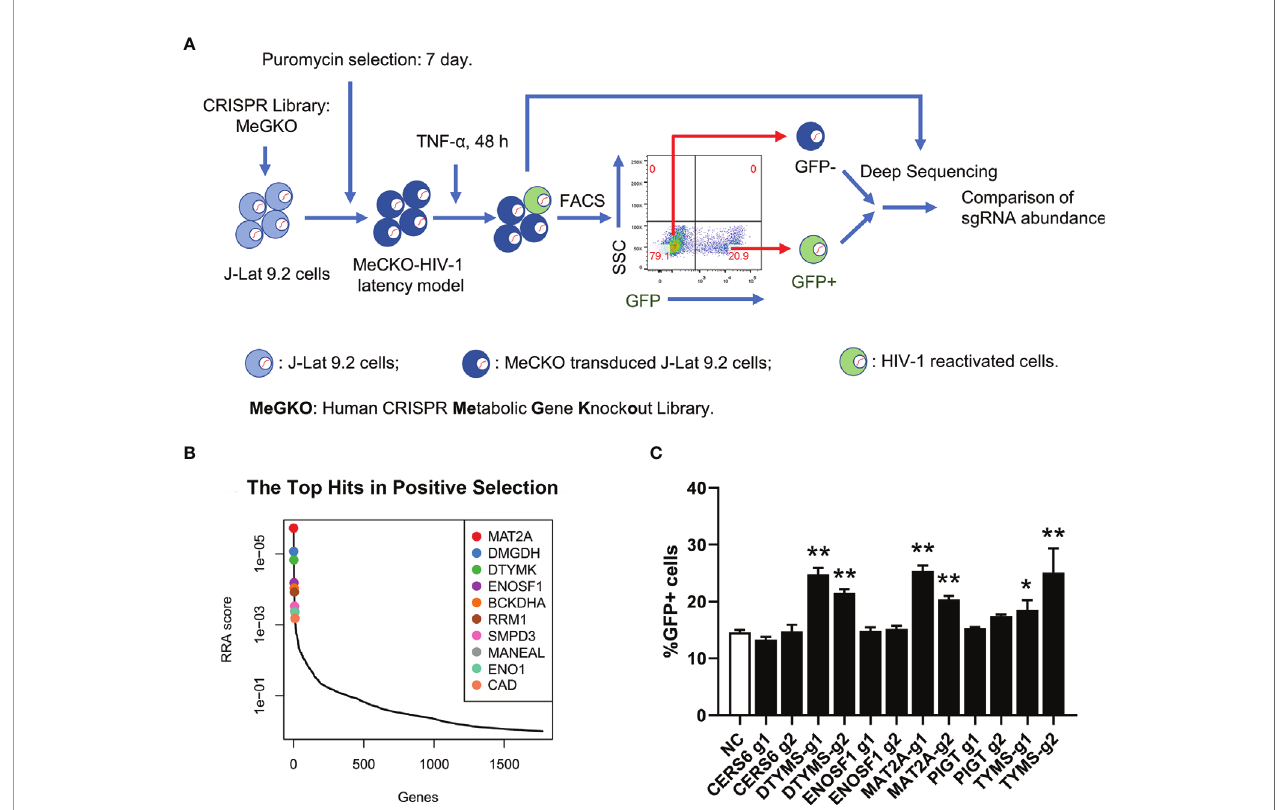
FIGURE 1 | A sub-pooled CRISPR screening of metabolic genes. (A) Schematic overview of CRISPR/Cas9 screen for the identi fi cation of metabolic genes controlling HIV-1 latency. (B) Distribution of RRA scores in GFP+ cells versus GFP- cells with positive selection. Top 10 hits were showed. (C) Flow cytometry analysis of the percentage of GFP positive cells in J-Lat 9.2 cells with TNF- a stimulation for 24 h after knockout of the candidate genes. Data were presented as mean ± SD from three independent experiments (Student ’ s t-test, *p < 0.05, **p <